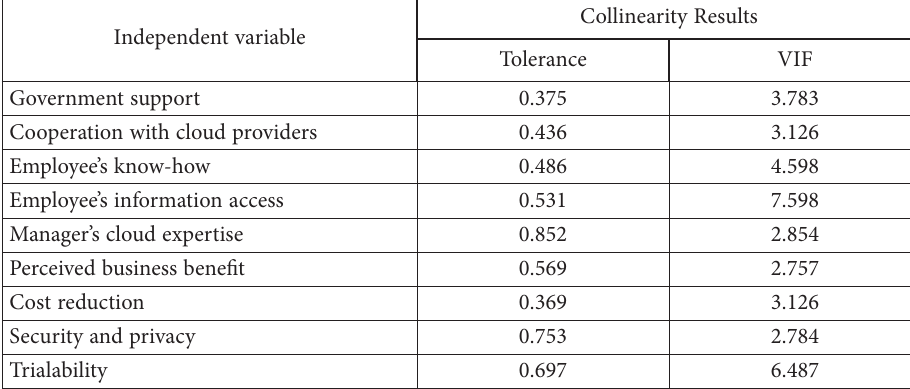
Table 12. Collinearity